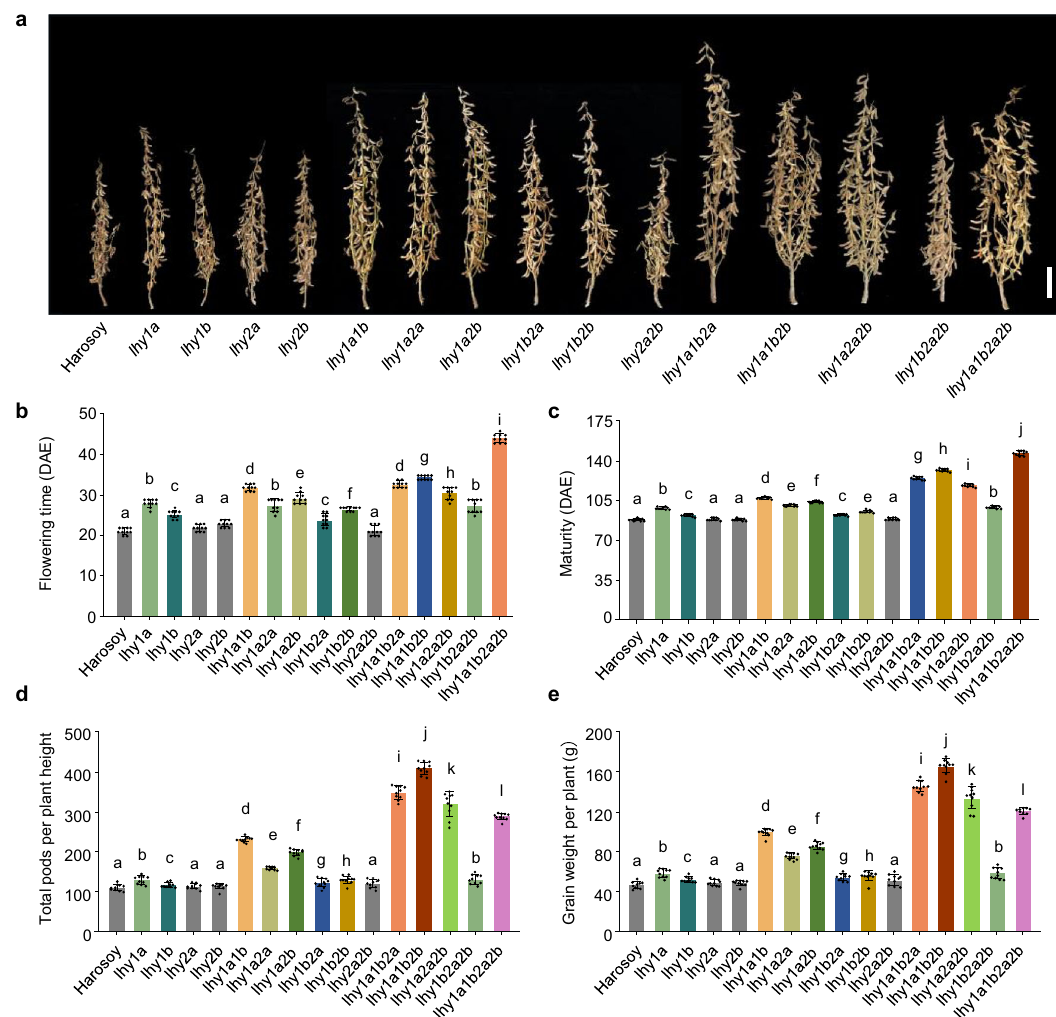
Fig. 2 Redundancy among four LHY genes regulates soybean fl owering time and yield under SD (12 h light/12 h dark) conditions. a Phenotypes of lhy mutants. Scale bar, 10 cm. b Flowering time. c Time to maturity. d Total pods per plant height. e Grain yield per plant. All data were given as mean ± s.e.m. ( n = 10 plants), the value of each plant was represented by a dot. The presence of the same lowercase letter above the histogram bars in ( b – e ), denotes nonsigni fi cant differences across the two panels ( P > 0.05). One-way ANOVA was used to generate the P values. Source data underlying Fig. 2b – e are provided as a Source Data fi